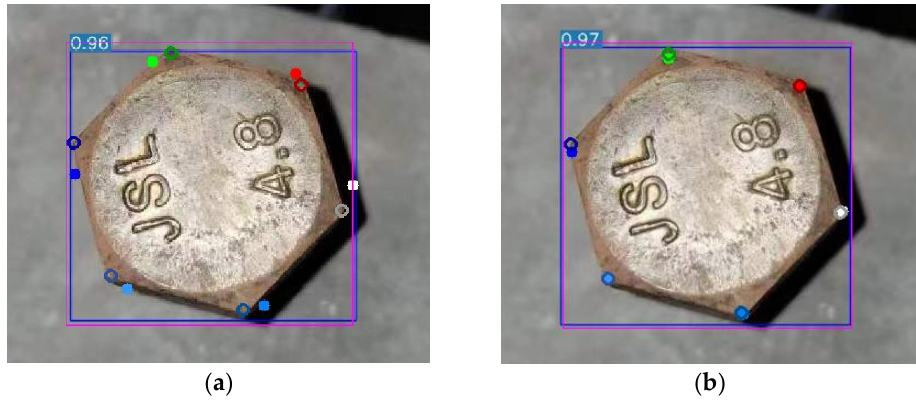
Figure 20. Detection box and key-points visualization ( a ) Detection results of the “ 100 real ” model; ( b ) Detection results of the “ 200 real + 1200 synthetic ” model.